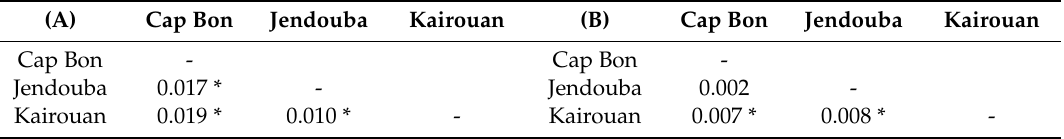
Table 5. Assessment of the genetic di ff erentiation by the geographic origin in M. persicae samples. The fixation index Fst was computed using ( A ) all clonal copies per multilocus genotype or ( B ) one single copy.